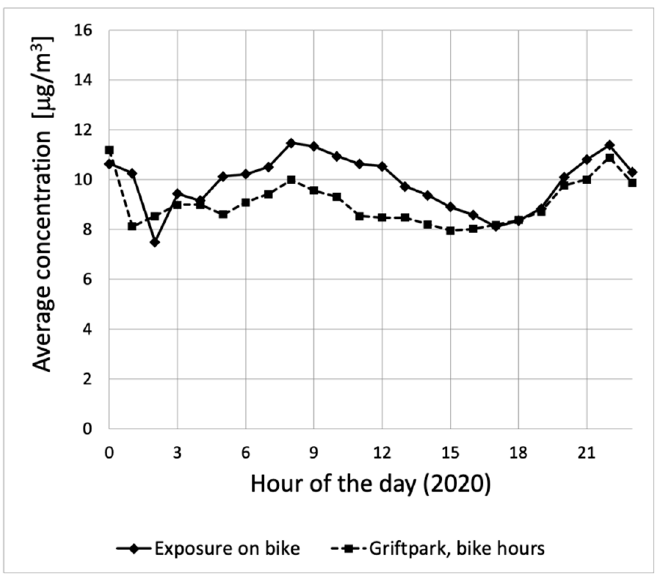
Figure 9. The average PM 2 . 5 concentrations during bicycle trips in 2020 as a function of the hour of the day. The average PM 2 . 5 concentrations at the urban background location “Griftpark” are also the day. The average PM 2.5 concentrations at the urban background location “Griftpark” are also shown for comparison. shown for